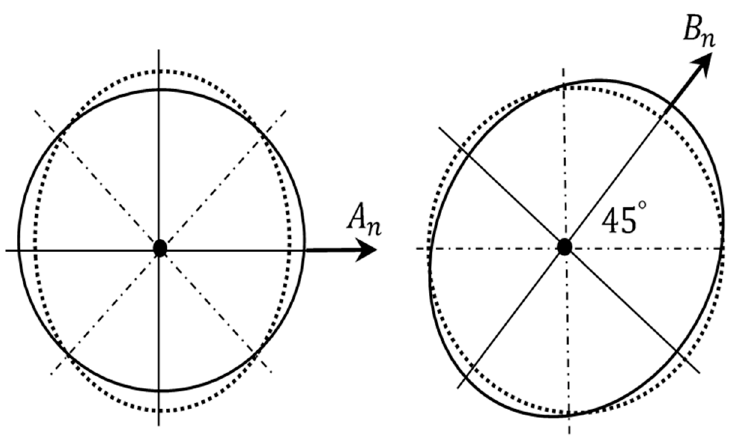
Figure 2. Visualization of primary direction 𝐴 (cid:3041) and secondary direction 𝐵 (cid:3041) of ring.